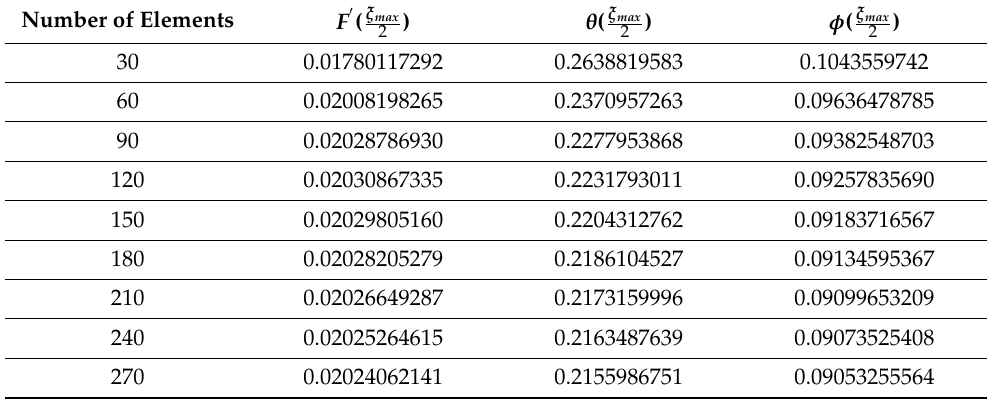
Table 2. Grid-independent analyses of concentration, temperature, and velocity at mid of 270 elements.